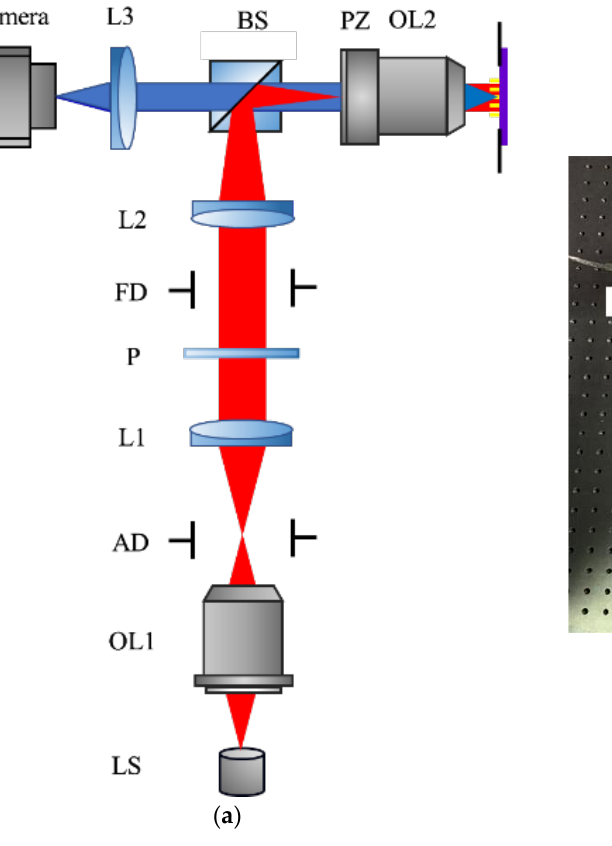
Figure 2. TSOM imaging system: ( a ) Schematic and ( b ) Photograph of the system. LS: LED light source (520 nm wavelength); OL1: objective lens (5×); AD: aperture diaphragm (diameter = 1 mm); L1: lens (focal length = 100 mm); P: polarizer; FD: field diaphragm; L2: lens (focal length = 150 mm); L3: lens (focal length = 200 mm); BS: beam-splitting prism; PZ: piezoelectric objective locator; OL2: objective lens (50×); Collection numerical aperture (CNA) of the objective lens OL2 is 0.55. Since AD coincides with the rear focal plane of L1, the light spot is magnified by 1.5 times after passing L1 and L2; therefore, the size of the light spot on the rear focal plane of the objective lens is Dspot = 1.5 mm . Illumination numerical aperture (INA) is calculated as INA = sin θ = tan θ = Dspot = 0.1875 , in 2 2 2×f OL2 which θ is the angle of illumination and f OL2 is the focal length of OL2.